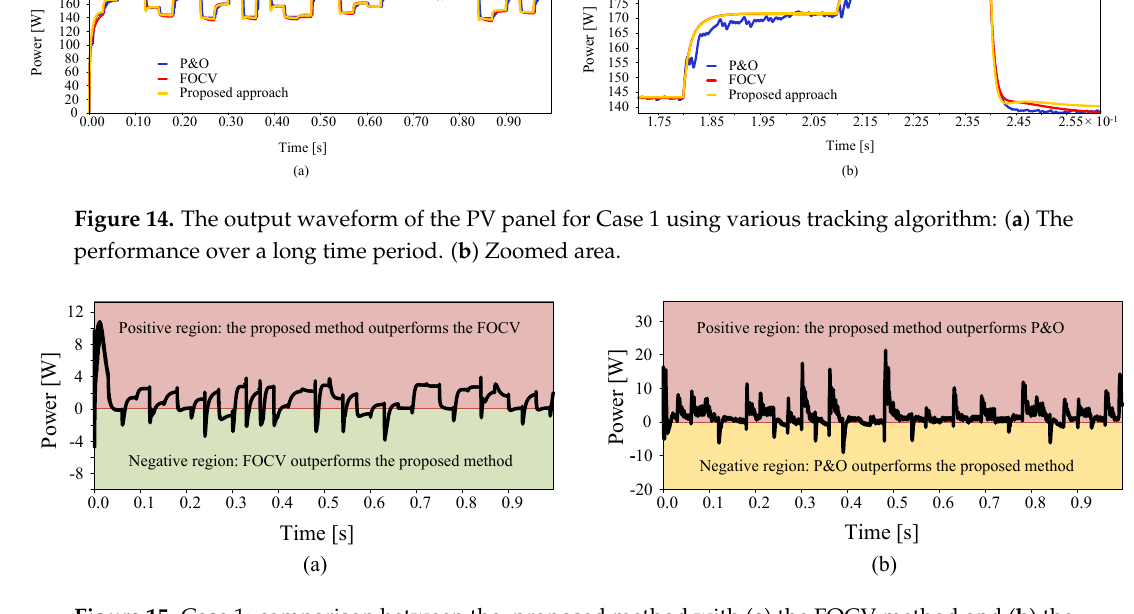
Figure 15. Case 1: comparison between the proposed method with ( a ) the FOCV method and ( b ) the P&O